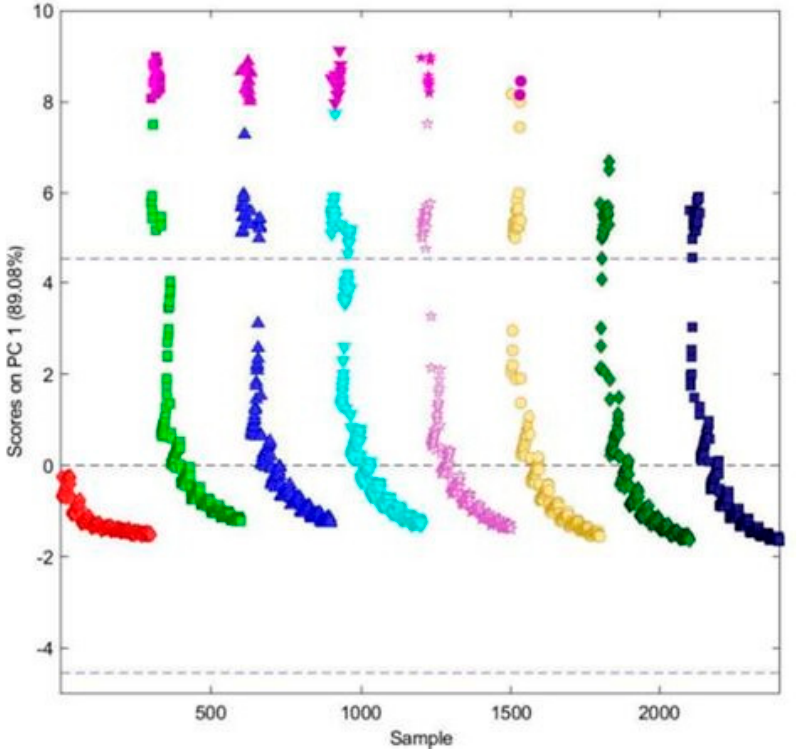
Figure 6. Collected data during 8 replicas of IPA samples with 0.01 mg/L of diacetyl. Purple samples are the reported outliers each color correspond to a single one measurement replicate.